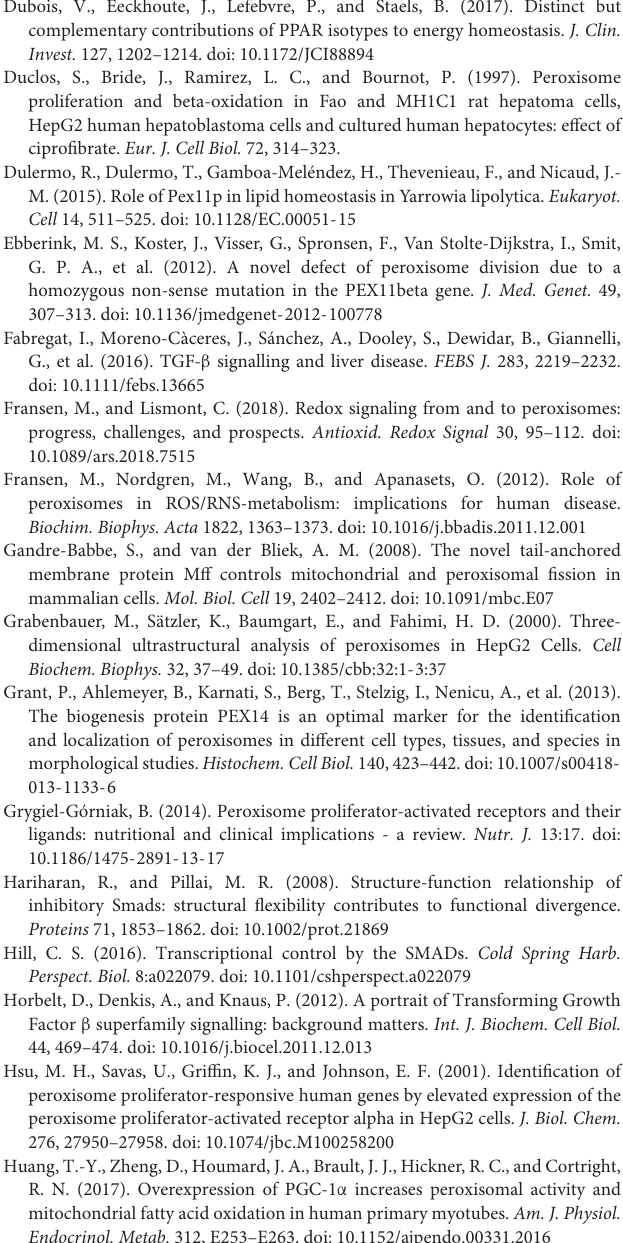
Supplementary Table 2 | Plasmids generated in this study. Supplementary Table 3 | Human qPCR primers used in this study. Supplementary Table 4 | Primary and secondary antibodies used in this study. Supplementary Table 5 | Generation of PEX11-deficient HeLa cells. Supplementary Table 6 | Predicted SMAD2/3 binding sites in peroxisomal gene promoters. Start and end position expressed in relation to 10 kb region